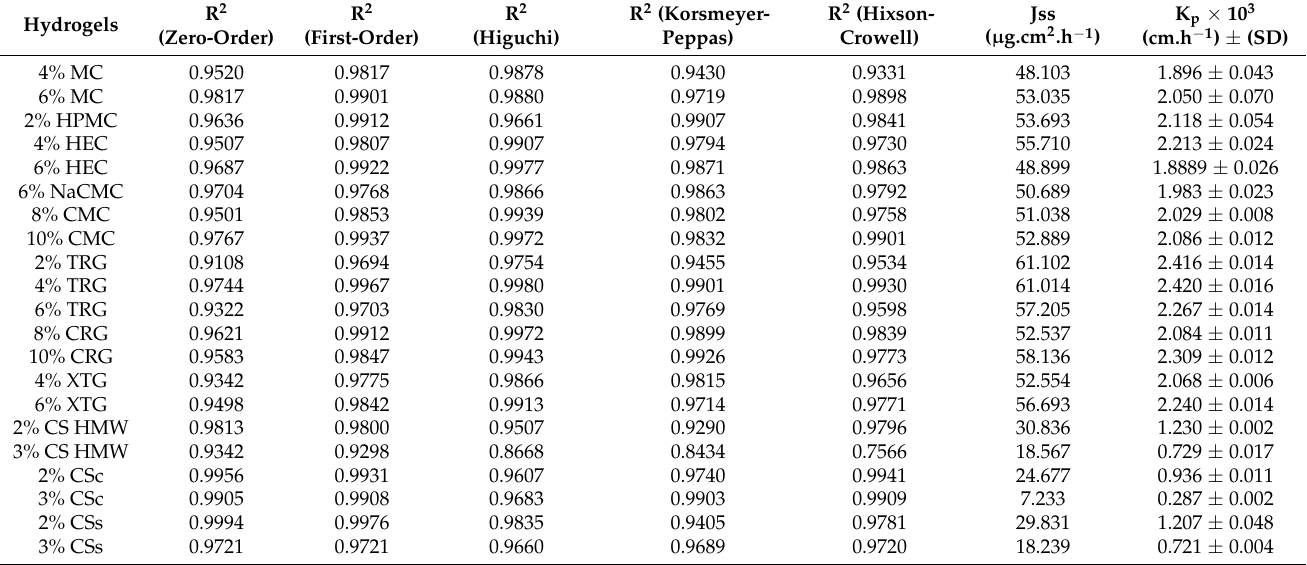
Table 1. The values of the coefficient of determination (R 2 ), flux (Jss), and permeation coefficient (K p ) with standard deviation (SD) for the individual drug (IBU) release kinetic models of selected polysaccharide